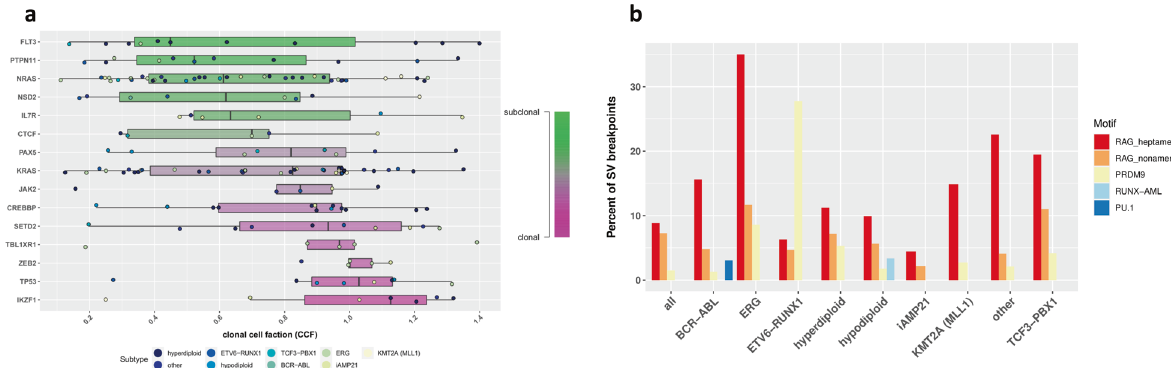
Fig. 6 Driver clonality and SV breakpoint enrichment. a Driver gene mutation (SNV/indels) clonality. Box and whiskers plot showing the proportion clonal mutations for ALL driver genes. Each circle represents a mutation, coloured according to disease subtype, for tumours with multiple mutations in the same gene the variant with the highest clonal cell fraction is retained. b Structural variant motif enrichment. Bar chart showing motif enrichment at SV breakpoints. Two 100 bp of sequences fl aking each breakpoint of an SV were extracted and analysed using HOMER. Y-axis; percent of extracted sequences containing